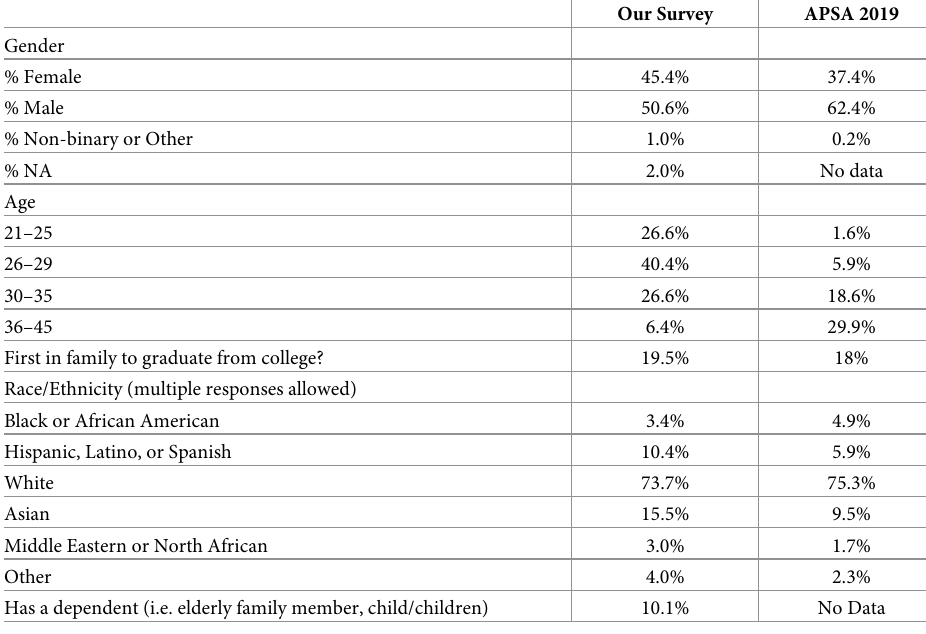
Table 1. Characteristics of the